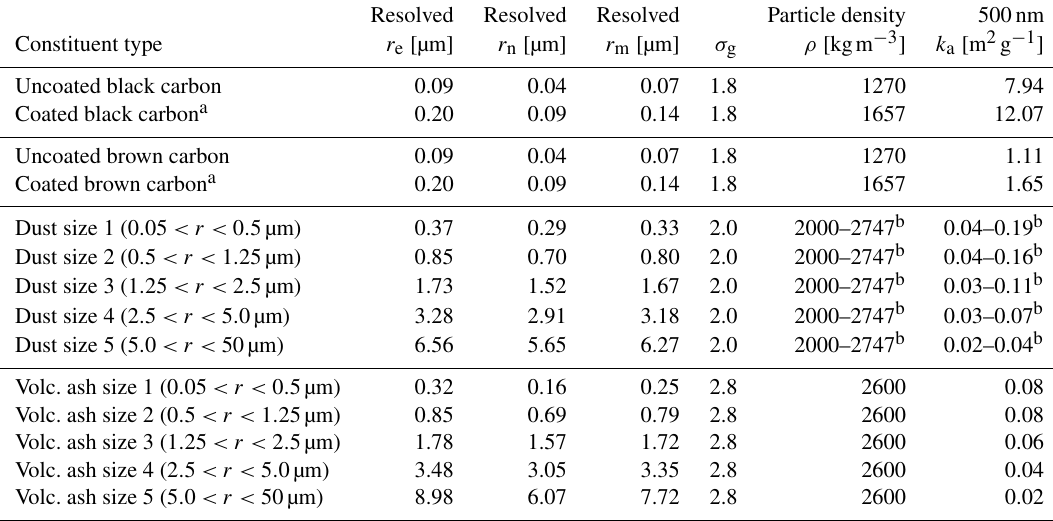
Table 2. Light-absorbing constituent properties. Resolved Resolved Resolved Particle density Uncoated black